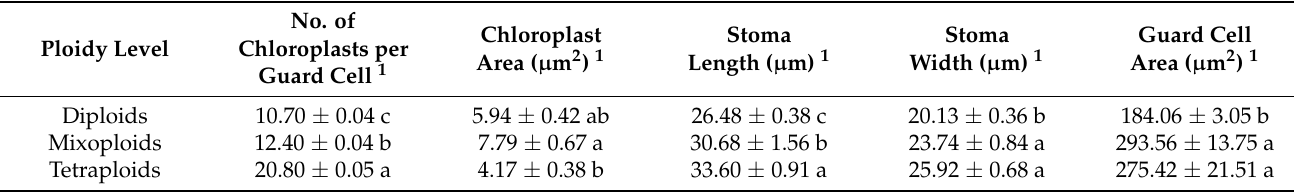
Table 3. Measurements of the cytological traits of leaf epidermal cells of diploid, mixoploid, and tetraploid C. officinale plants.